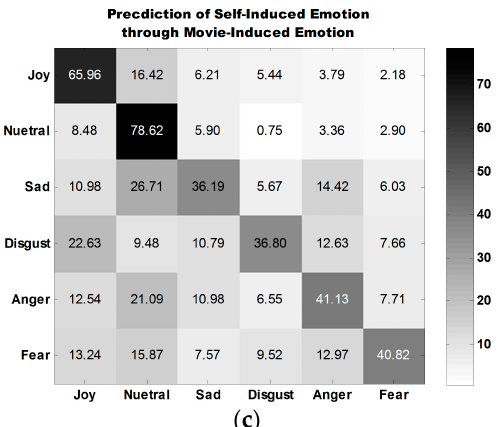
Figure 10. Average confusion matrix for the classification of emotions of 30 participants into six discrete categories. ( a ) Average confusion matrix for movie-induced emotion recognition. ( b ) Average confusion matrix for self-induced emotion recognition. ( c ) Average confusion matrix for prediction of self-induced emotion through movie-induced emotion.